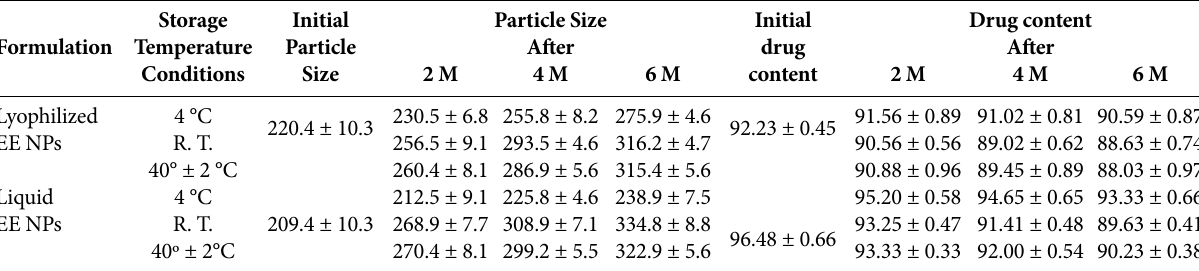
Table 12. Stability data of lyophilized EENPS and EENPS for the six-month stability study.